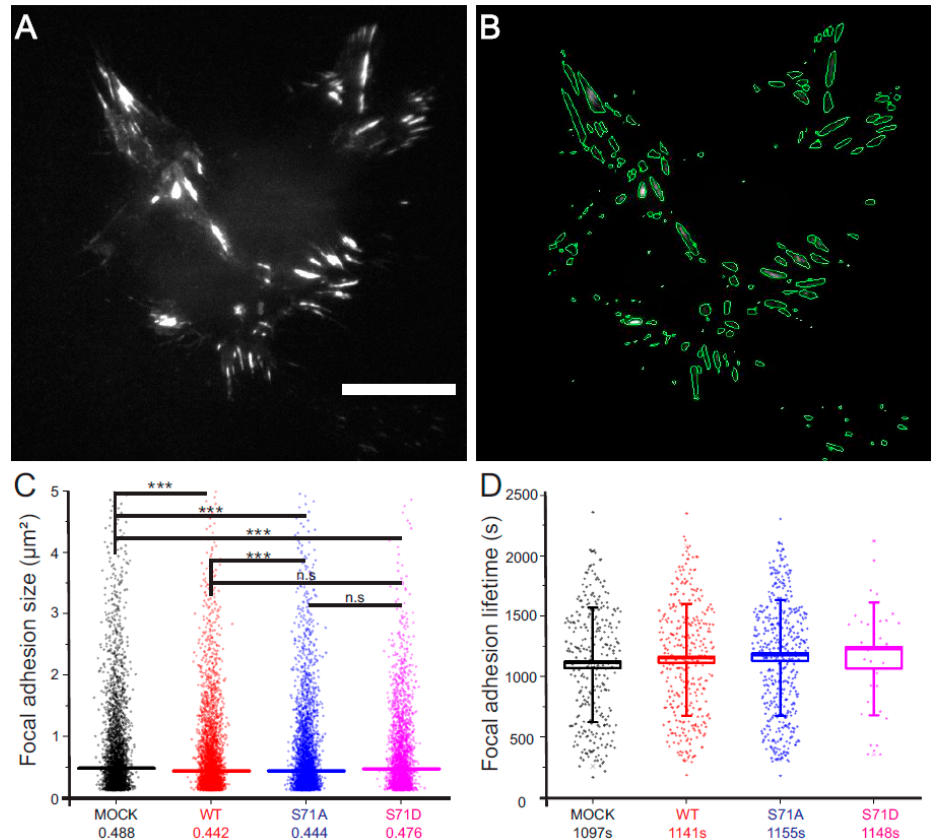
Figure 2. Expression of wild-type, S71-phospho-mimicking or -deficient vimentin changes the size but not the turn-over of cell-matrix adhesion. ( A ) The GFP-Paxilin signal in a representative cell acquired by total internal reflection microscopy and, thereafter, ( B ) computationally processed to show the segmented areas defined as FAs. Scale bar; 20 µm; ( C ) the size of FAs under the different conditions, as indicated. The horizontal colored line corresponds to the median. *** p < 0.001 (Student’s t -test); and ( D ) lifetimes of the FAs, as indicated. The box corresponds to the standard error of the mean, and the whiskers to the standard deviation. Mean values are indicated by the number under each condition.